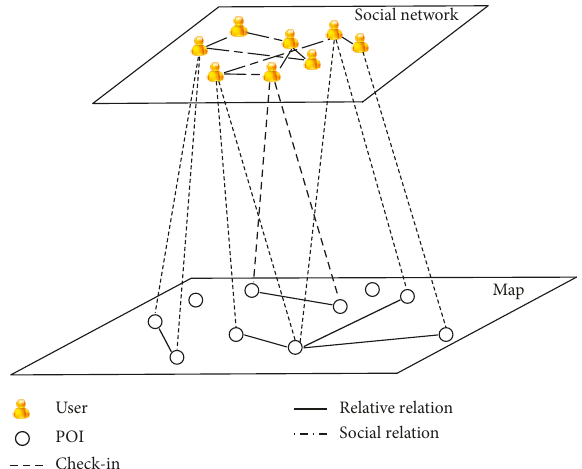
Figure 2: POI recommendation scenario in LBSNs, which consists of three kinds of information: the user-POI check-in matrix, social network, and POI-POI